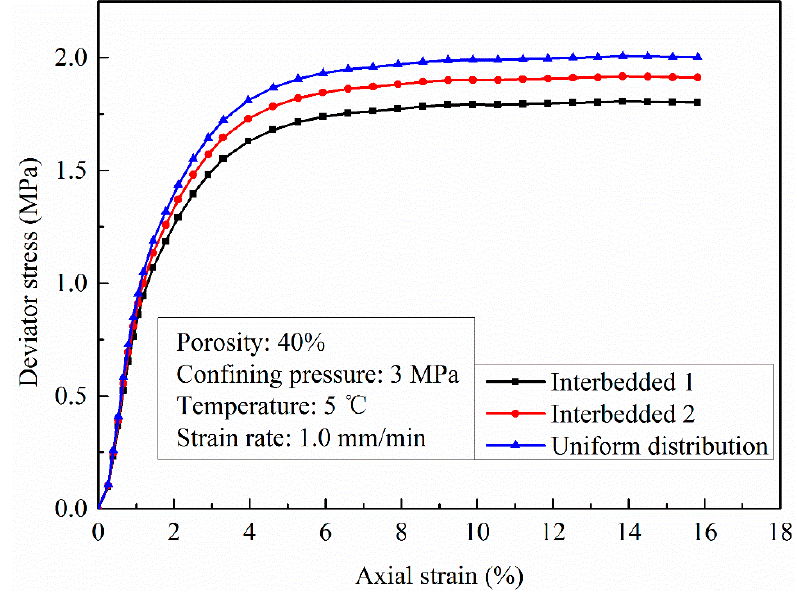
Figure 10. Stress–strain curves of HBMS with different existence forms of hydrate.